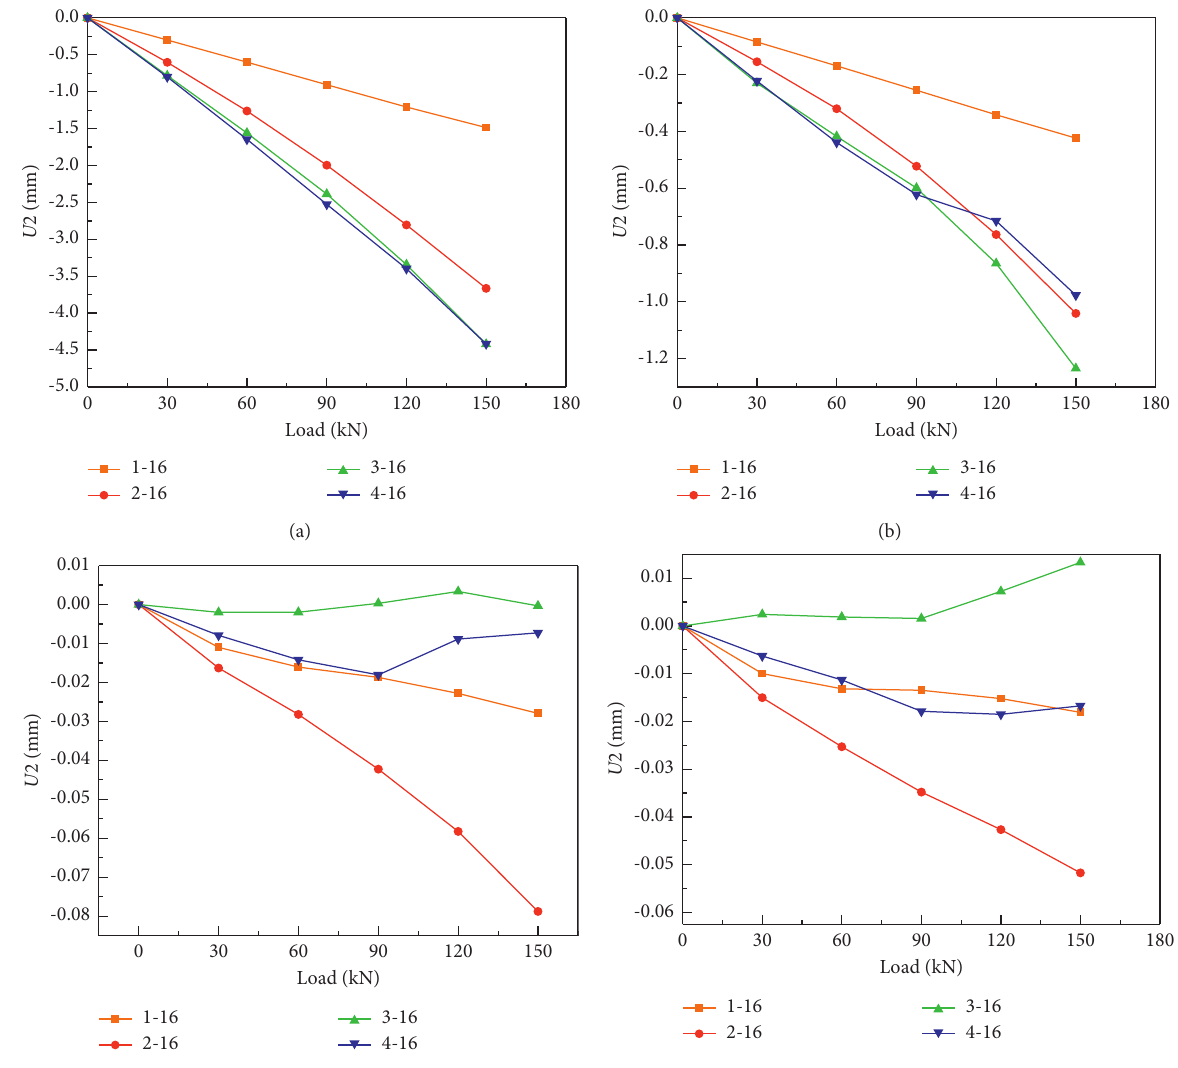
Figure 9: U2: (a) P1; (b) P3; (c) P5; (d)